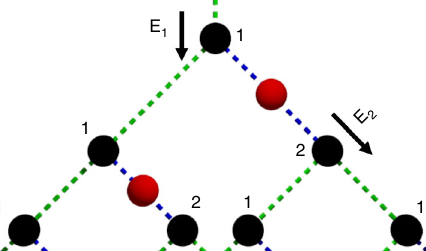
Fig. 7 Schematic of the ∞ -D extension of the (10,3)-b lattice. This lattice when used as the logical graph with node colors as shown yields λ c ≈ 0.5898. Percolation threshold was evaluated analytically NATURE COMMUNICATIONS| (2019) 10:1070